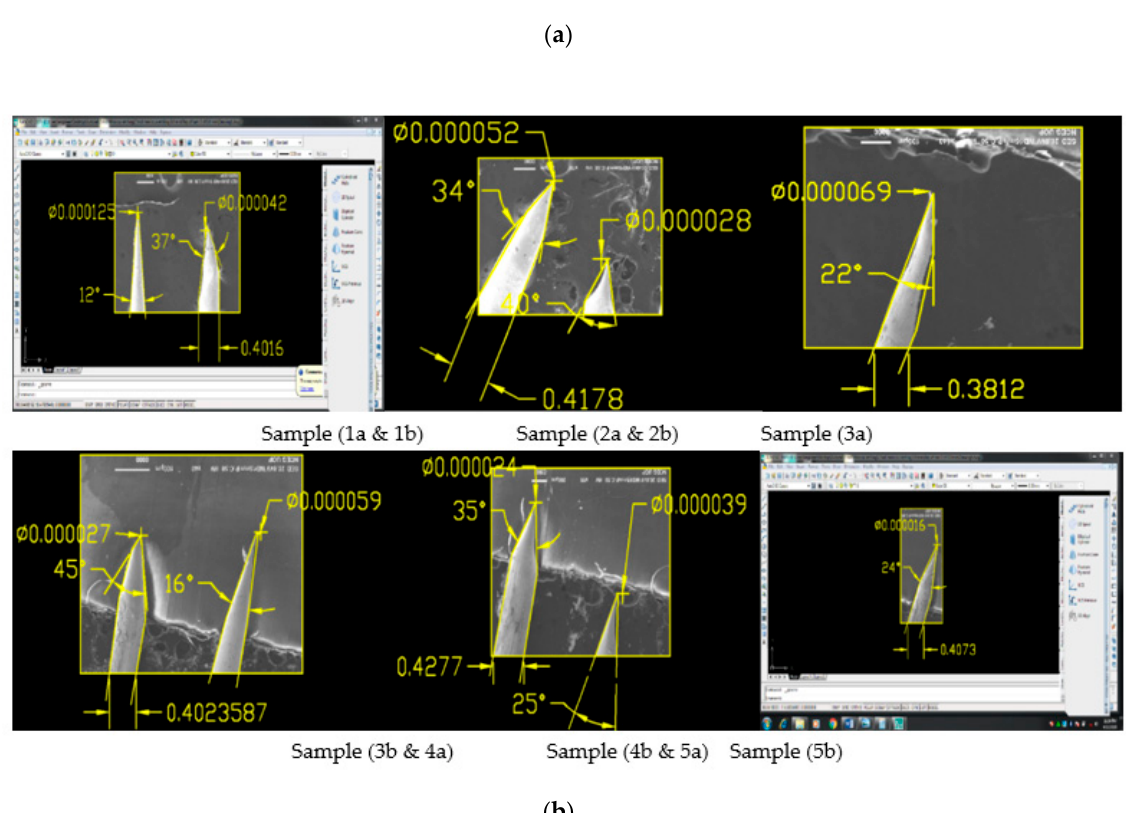
Figure 5. ( a ) SEM Images showing Sample 1a having applied voltage of 6.6 V in 2M NaOH solution; ( b ) SEM Images of 0.4 mm tungsten tips showing Sample 1a cone angle and tip diameter measured using AutoCAD Software.